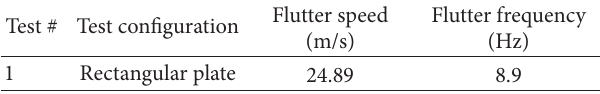
Table 2: Wind tunnel flutter test results for the rectangular plate.